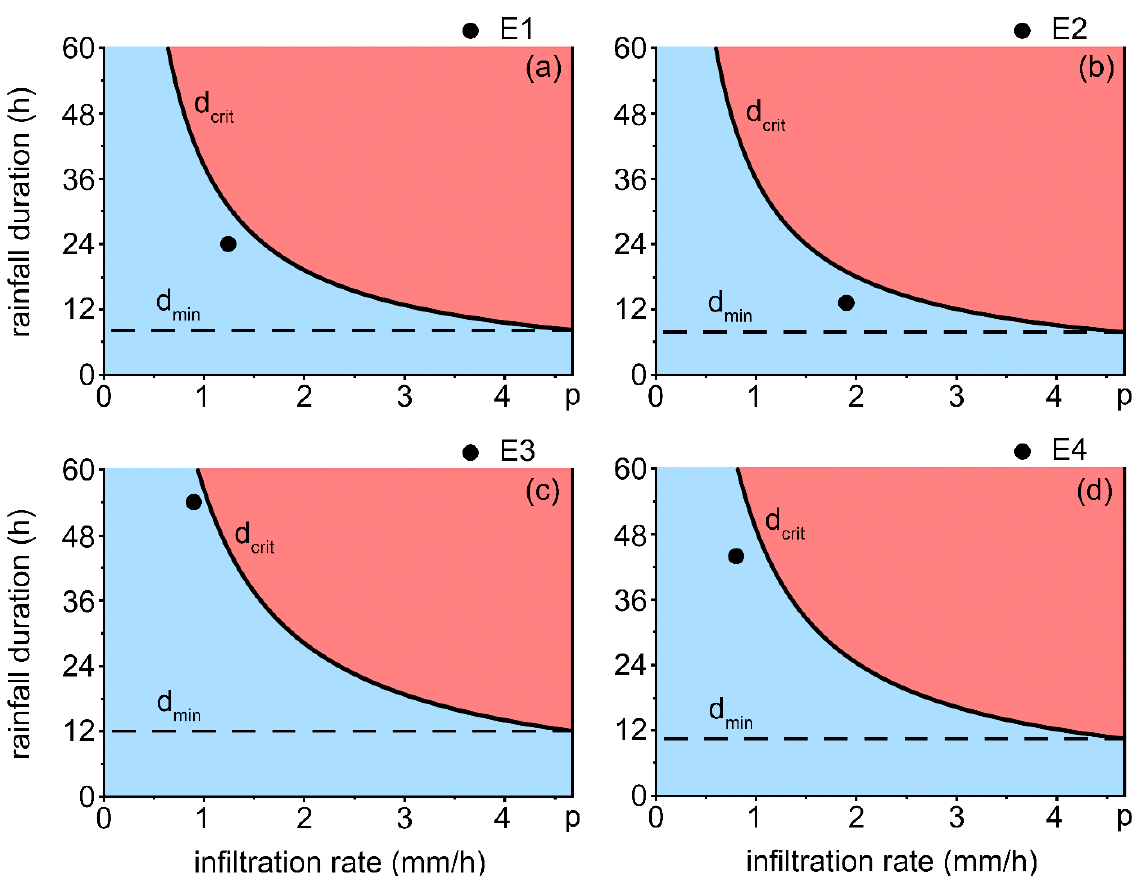
Figure 7. Critical curve calculated at the depth of the slip surface where ( a ) u wo = − 0.65 kPa; ( b ) u wo = − 0.50 kPa; ( c ) u wo = − 1.60 kPa; and ( d ) u wo = − 1.20 kPa. The black points represent the rain events E1, E2, E3 and E4.